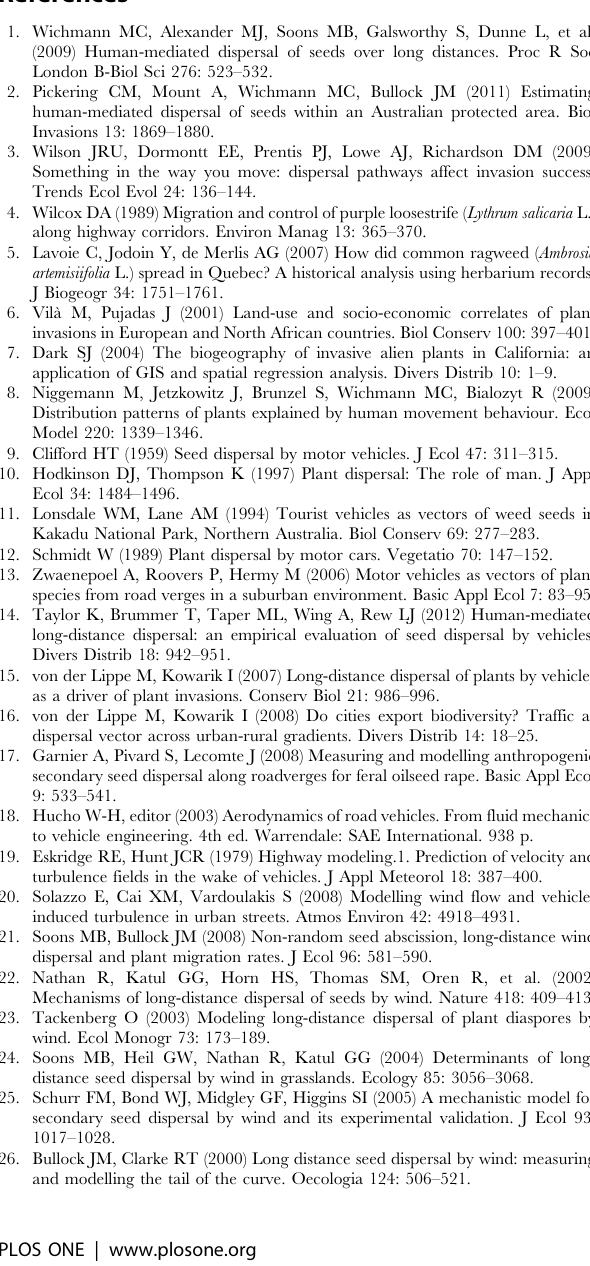
Table S1 Parameter estimates and AIC of the Lognor- mal and Wald function for dispersal at three different numbers of vehicles